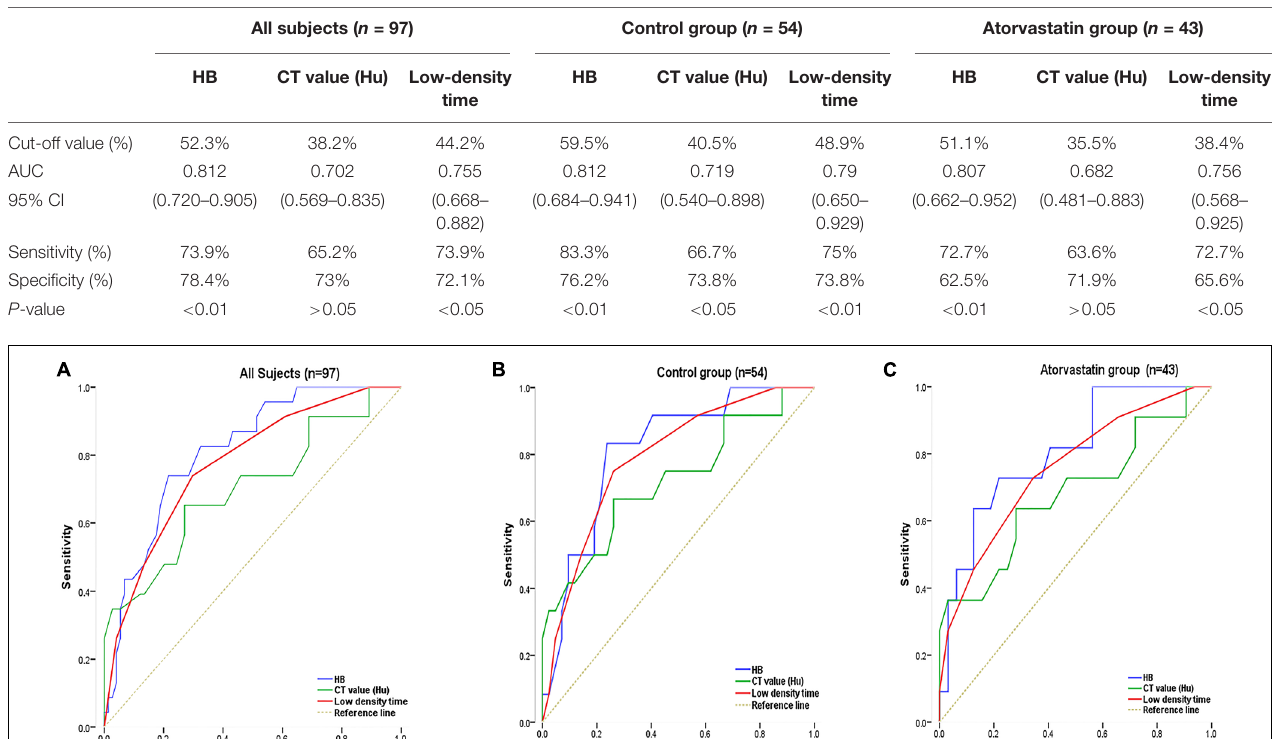
TABLE 4 | Indices of lowest relative factors for predicting recurrence.